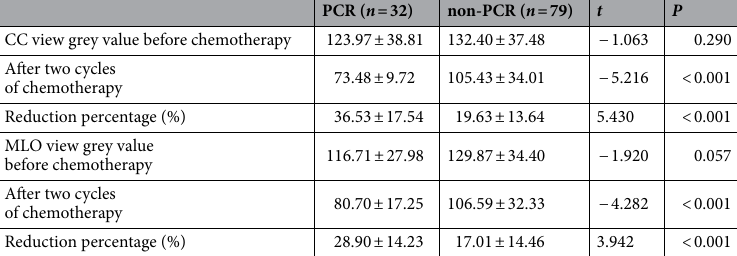
Table 2. Comparison of the percentage of grey value reduction between PCR and non-PCR